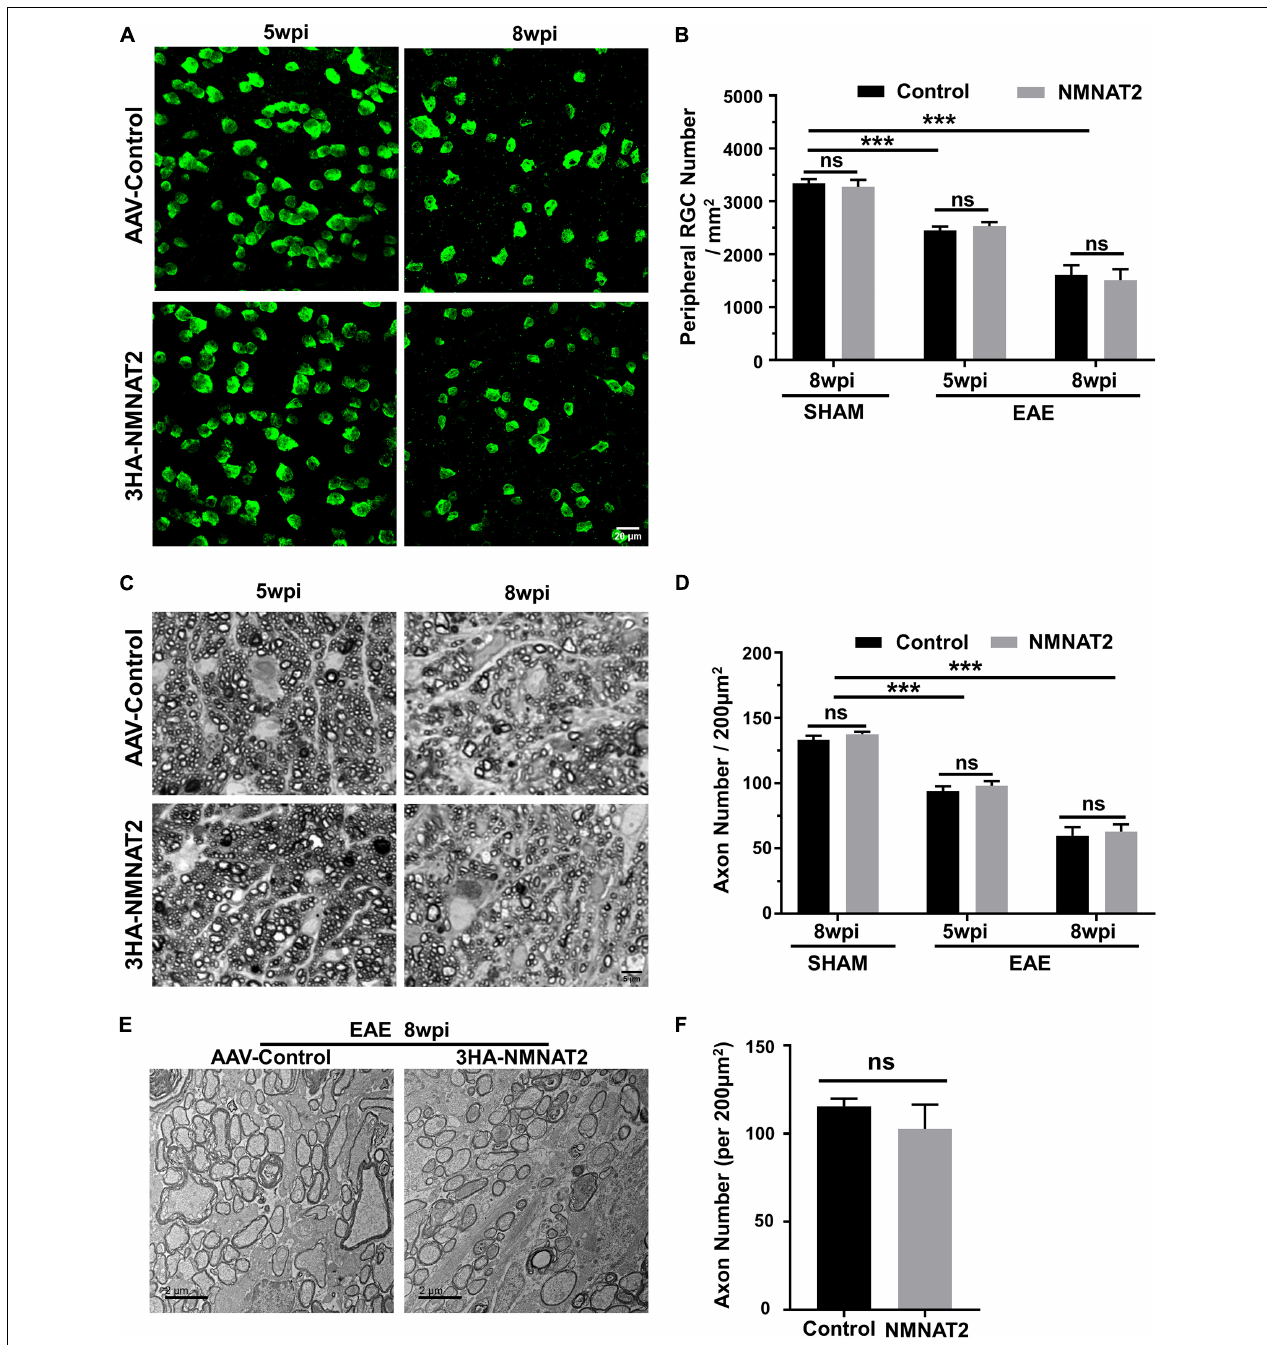
FIGURE 4 | Histological studies confirmed no neuroprotection of EAE RGCs or ON by NMNAT2 overexpression. (A) Confocal images of peripheral flat-mounted retinas showing surviving RBPMS-positive (green) RGCs at 5 and 8 wpi in the EAE mice. Scale bar, 20 µ m. (B) Quantification of surviving RGCs in EAE and sham mice at different time points after immunization. n = 10 at 5 wpi; n = 6 at 8 wpi; n = 3 of the sham mice. Data are presented as means ± SEM, *** p < 0.001, one-way ANOVA with Tukey’s multiple comparisons test. Comparison of NMNAT2-injected eyes and contralateral control eyes injected with control AAVs, ns, no significance, paired two-tailed t -test. (C) Light microscope images of semi-thin transverse sections of the ON with PPD staining. Scale bar, 5 µ m. (D) Quantification of surviving axons in the EAE ONs at different time points. n = 10 at 5 wpi; n = 6 at 8 wpi; n = 3 of the sham mice. Data are presented as means ± SEM, *** p < 0.001, one-way ANOVA with Tukey’s multiple comparisons test. Comparison of NMNAT2-injected eyes and contralateral control eyes injected with control AAVs, ns, no significance, paired two-tailed t -test. (E) Representative TEM images of the ON transverse section at 8 wpi in the EAE mice. (F) Quantification of the surviving axons imaged by TEM showed no significant difference between the ONs of NMNAT2-overexpressing eyes and the contralateral control eyes. n = 3. Data are presented as means ± SEM, comparison of NMNAT2-injected eyes and contralateral control eyes injected with control AAVs, ns, no significance, paired two-tailed t -test.